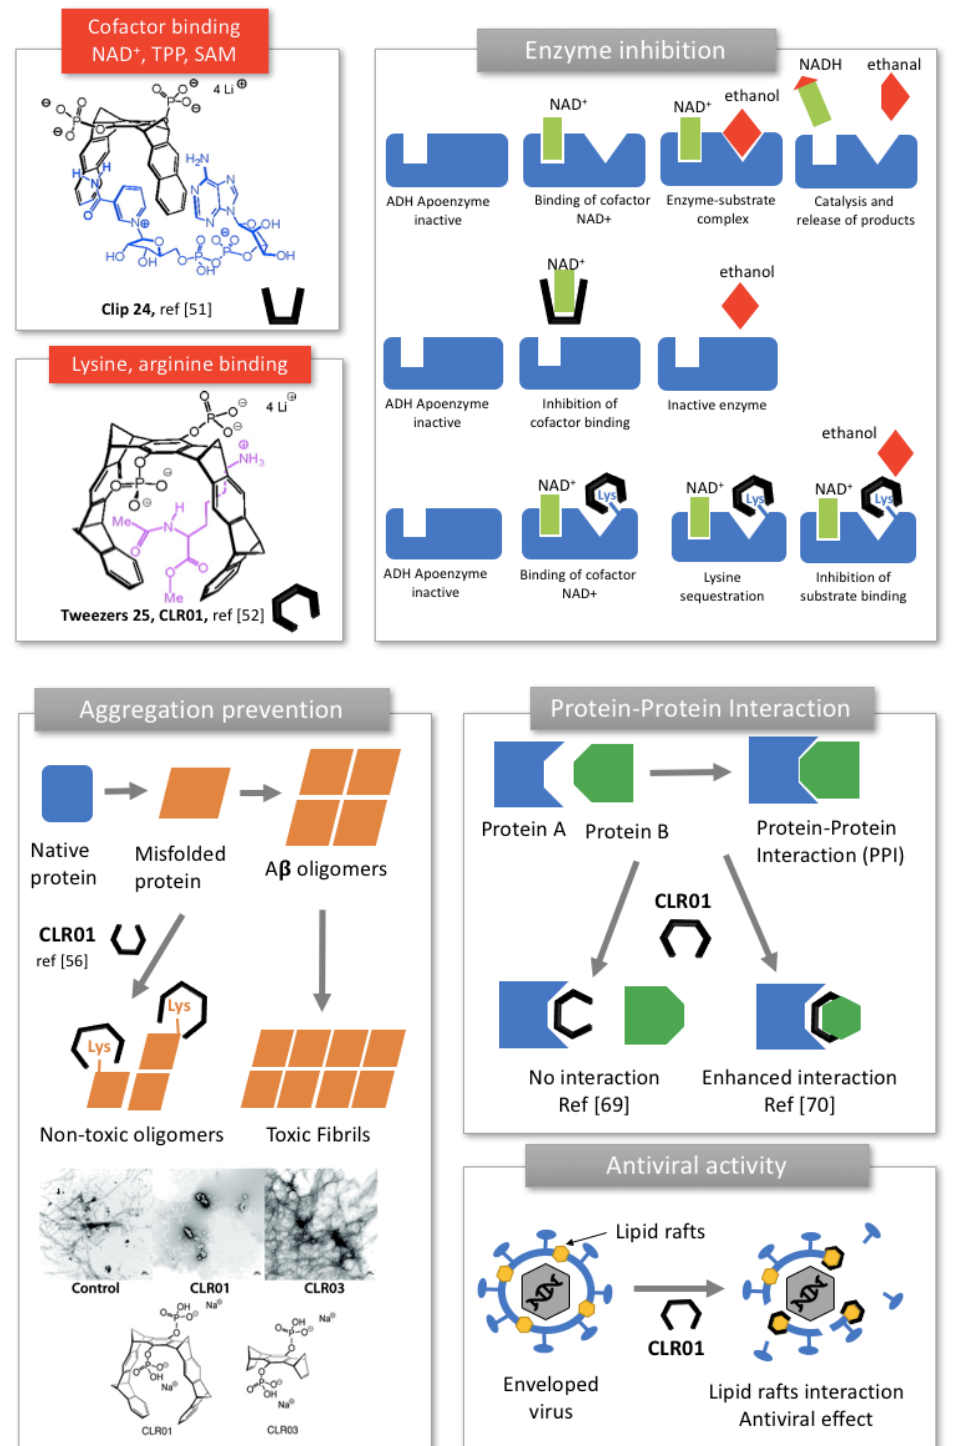
Figure 6. Phosphate molecular clip and tweezers developed by Klärner and their applications as enzyme inhibitors, illustrated by the alcohol dehydrogenase (ADH), protein aggregation inhibitors illustrated by amyloid β (A β ) fibril aggregation, protein-protein interaction modulator and antiviral agent. Adapted from [54,55].